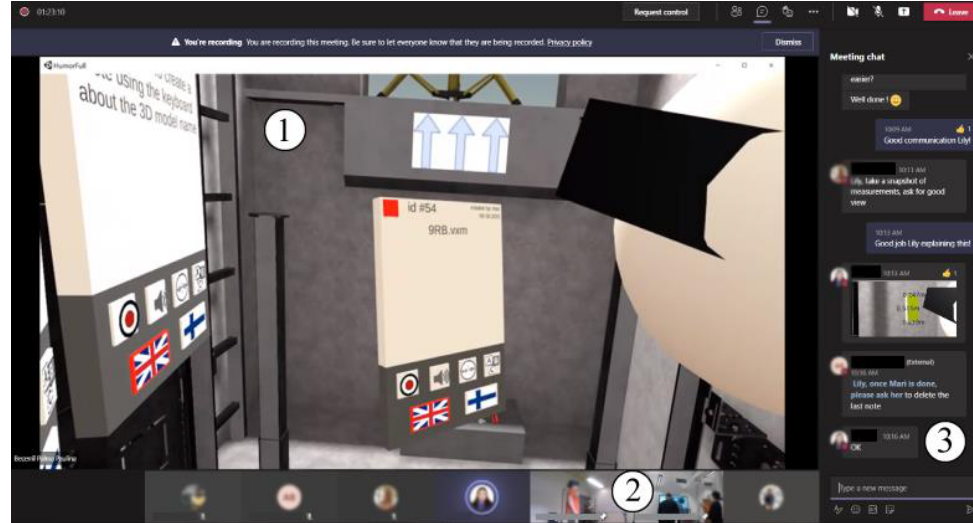
Figure 5. Screenshots from the test procedure: ( 1 ) streamed VR image from the VR-participant’s point-of-view, ( 2 ) streamed video of the VR-participants, ( 3 ) Teams chat activity.